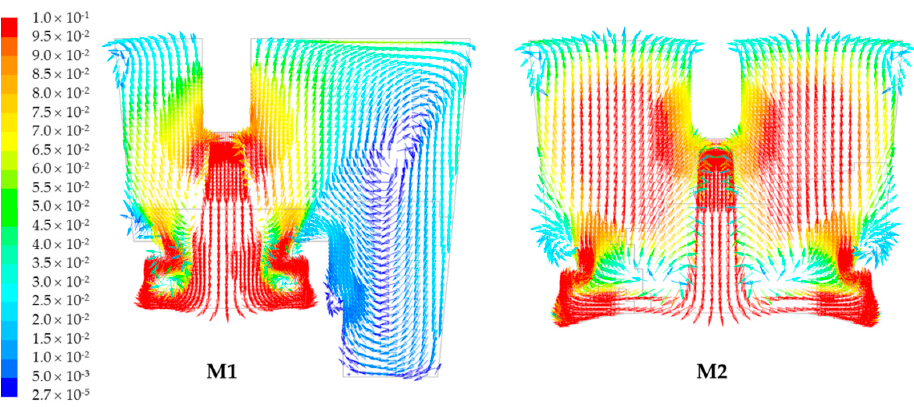
Figure 5. Comparison of velocity vectors (m·s − 1 ) and flow profiles for two tundish configurations in cross-sections through the centre of the shroud tube.